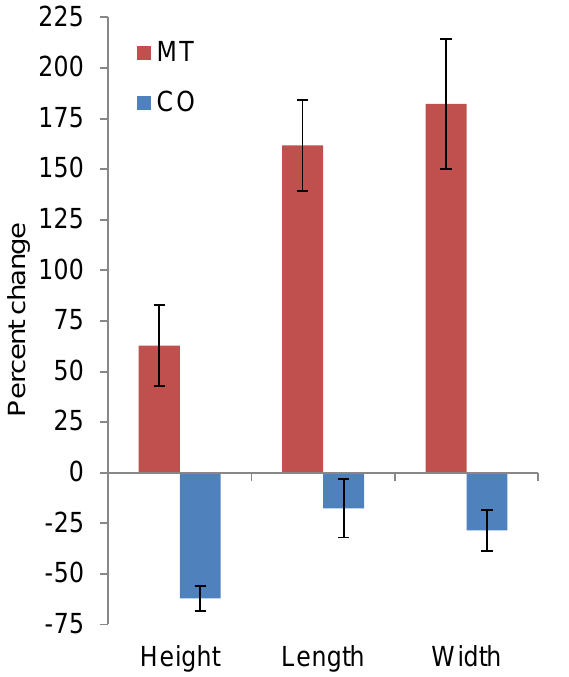
Figure 7. The mean percent vegetation cover in 2019 (four years after treatment with heather brash) in the unplanted plots ( n = 30) and plots planted with Calluna vulgaris ( n = 12) in 2016 at Meall nan Tarmachan (MT) and Coire Odhar (CO). Error bars are ± 1 SE. Table 5. GLM testing of percent vegetation cover in the plots at Coire Odhar (CO) and Meall nan Tarmachan (MT) in 2019; four years after treatment with heather brash and different netting types (C, J or B). Planting treatments are unplanted ( n = 30) or planted ( n = 12) with Calluna vulgaris cuttings in 2016. Interactions removed from the full model during simplification process: Site*Planting, F = 0.31, P = 0.583; Netting*Planting, F = 0.21, P = 0.814; Site*Netting*Planting, F = 0.67, P =